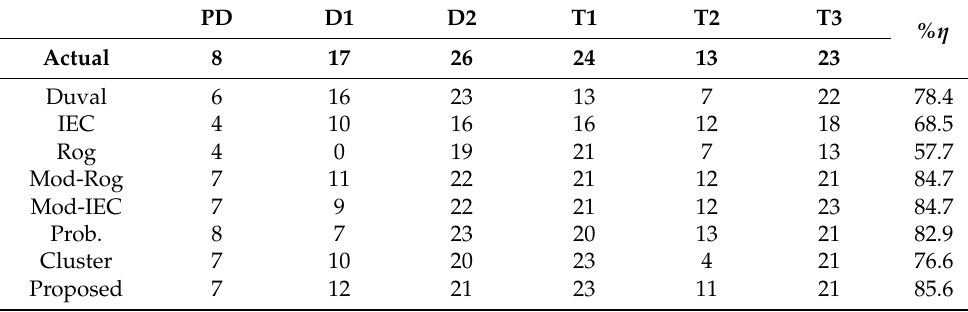
Table 11. Comparison between the proposed model and other